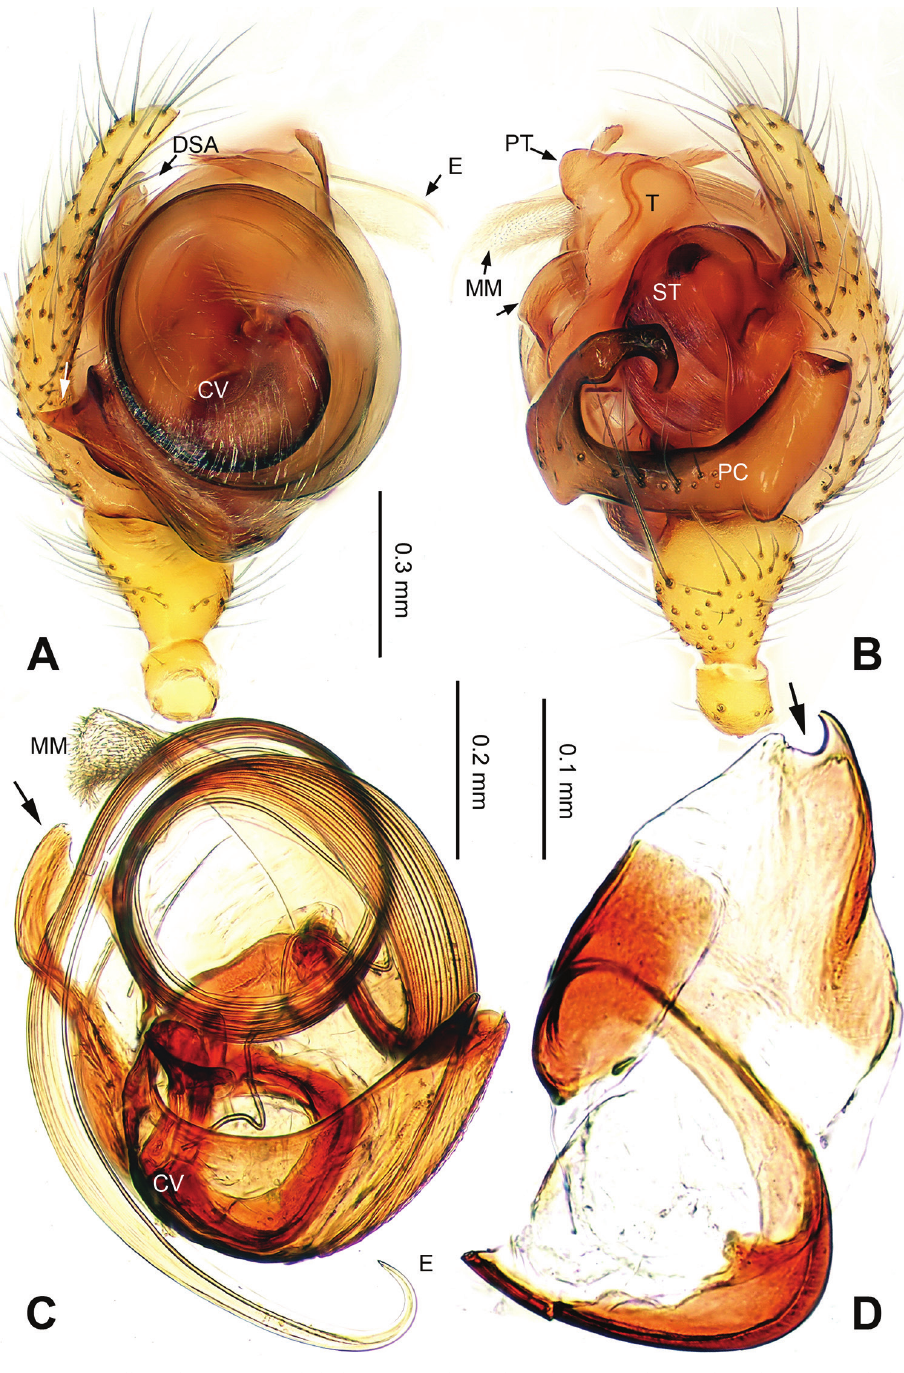
Figure 1. Callosa ciliata sp. n., male holotype. A Palp, prolateral view B Palp, retrolateral view C Embolic division, retrolateral view D Distal suprategular apophysis, retrolateral view. Scale bars: B as A